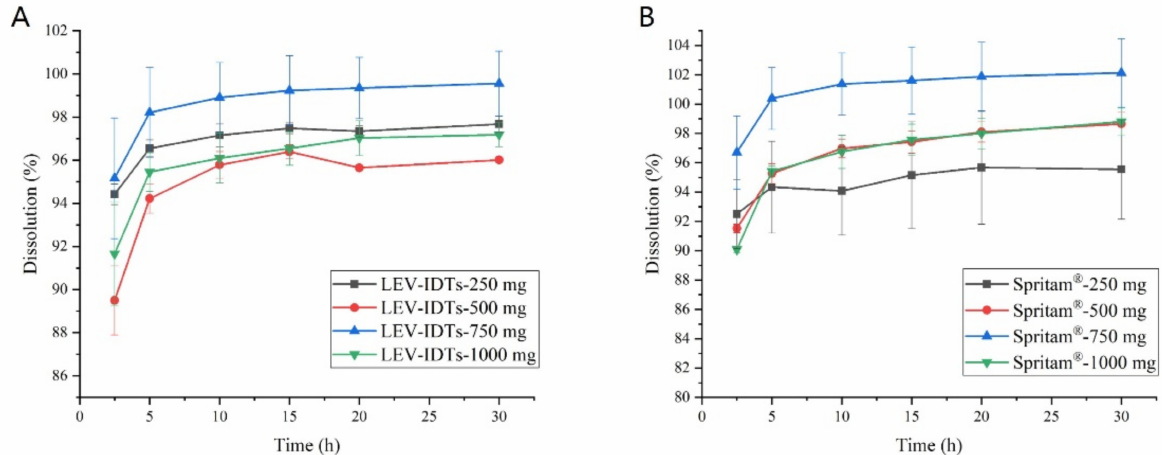
Figure 1. Dissolution curves of different sizes of 3D-printed ( A ) LEV-IDTs and ( B ) Spritam ® in pH 1.2 media ( n = 6).